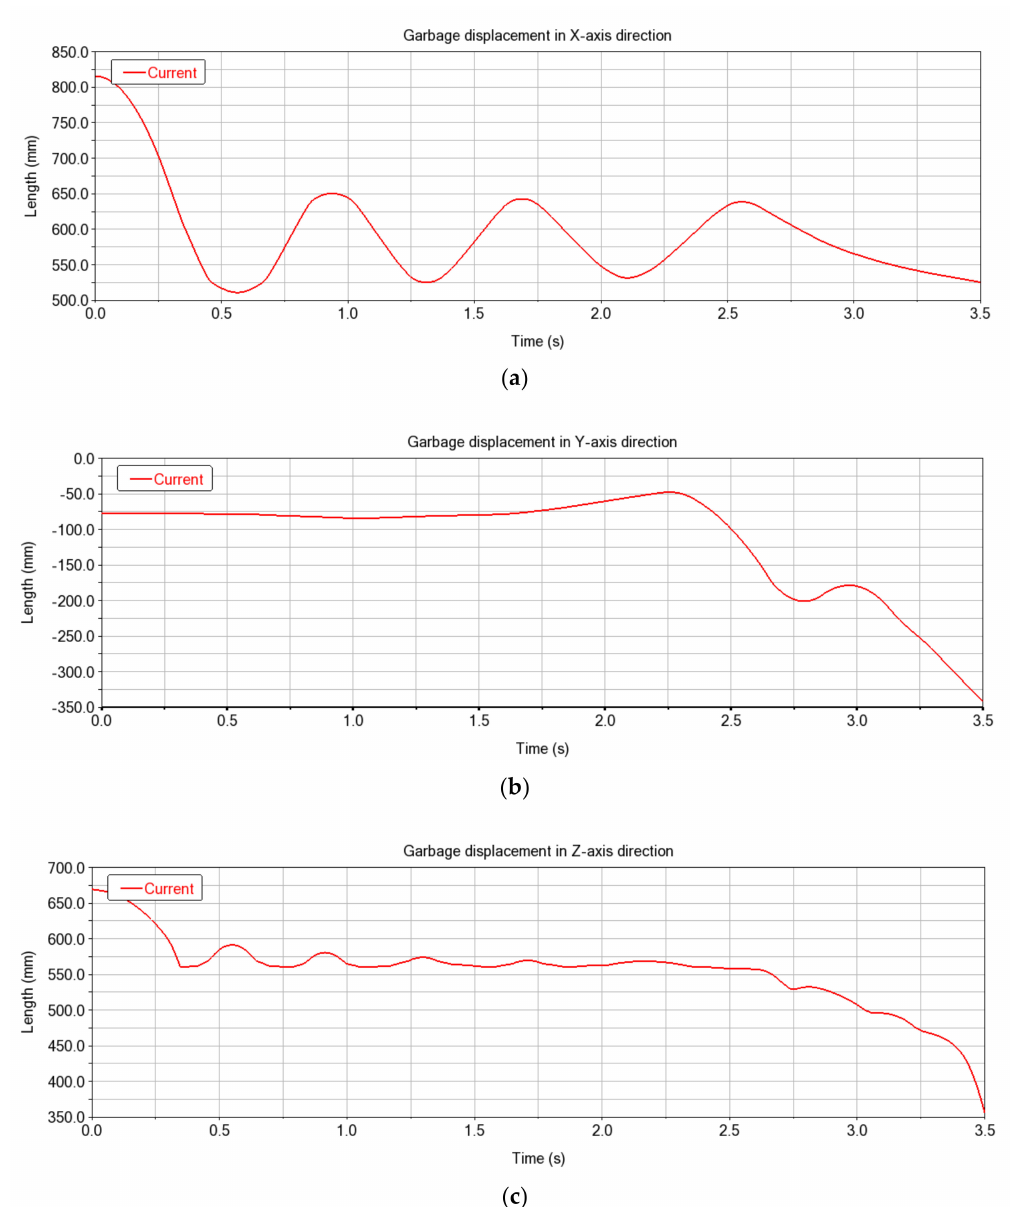
Figure 14. Displacement curve of the waste during the sorting process. The x-axis represents time, and the y-axis indicates the position coordinates of the material center of mass on each axis of the ground coordinate system: ( a ) X-axis direction; ( b ) Y-axis direction; ( c ) Z-axis direction. The displacement-time relationship for free fall is expressed as